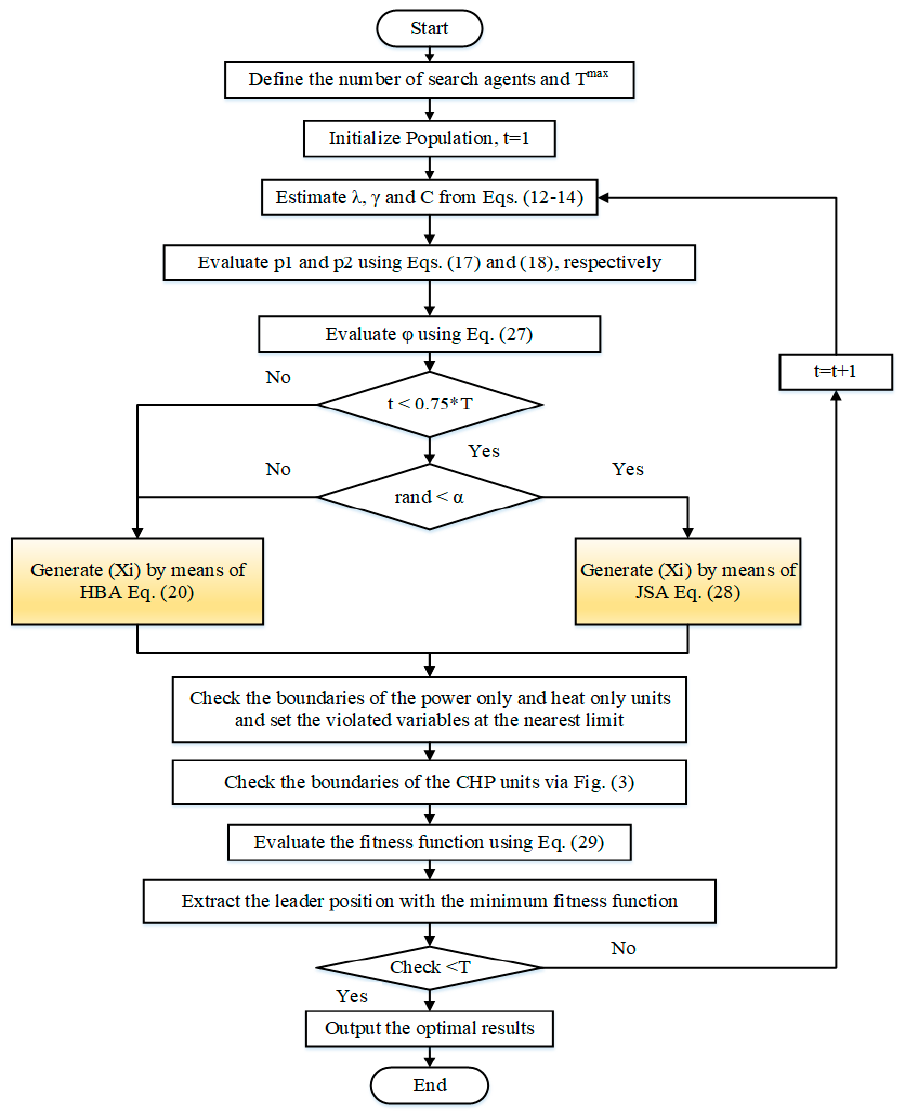
Figure 4. Flowchart of the proposed HBJSA.